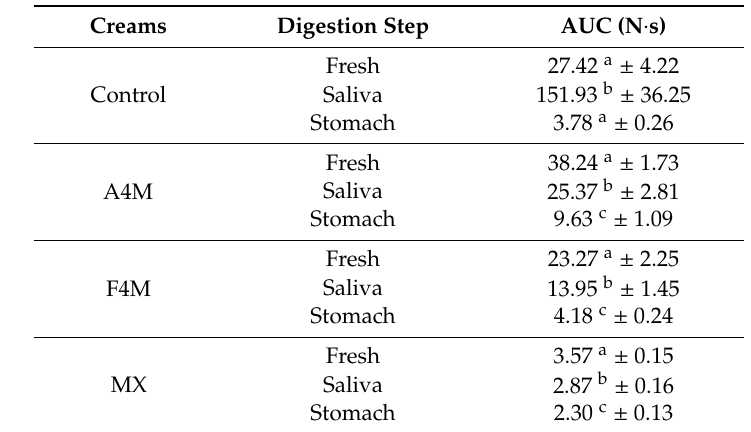
AUC: Area under the curve. abc Values with the same letter for each spread are not statistically di ff erent ( p <